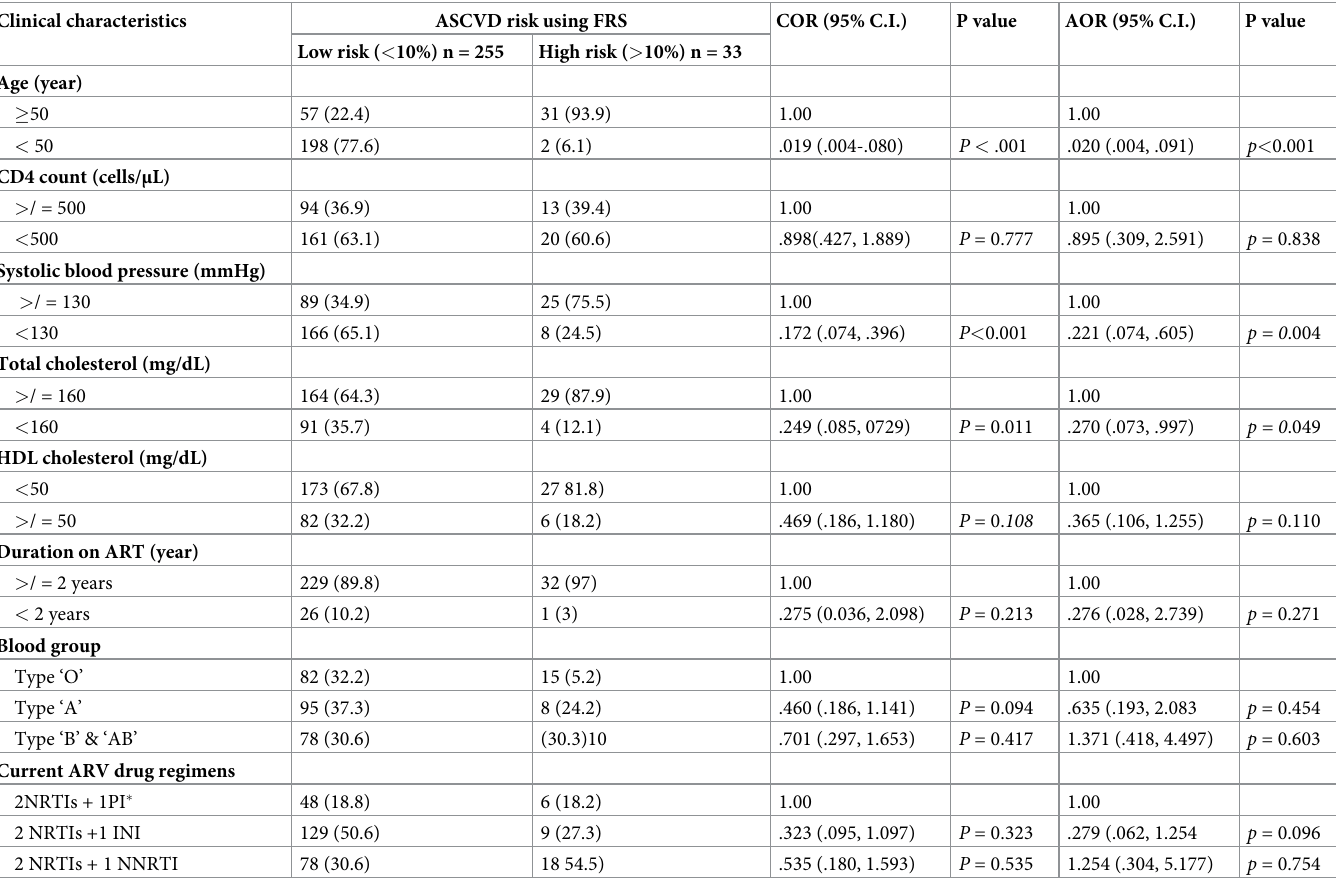
Table 3. Association between ASCVD risk using FRS and clinical characteristics among people living with HIV/AIDS at Zewditu Memorial Hospital, Addis Ababa, Ethiopia. Clinical